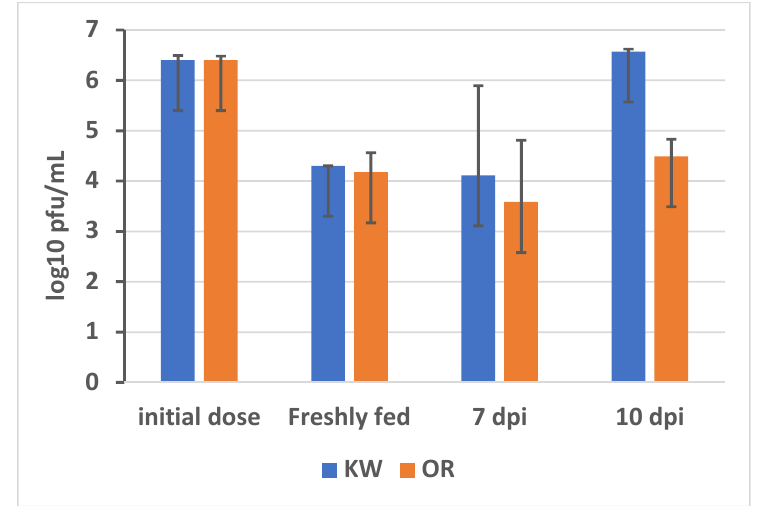
Figure 1. Zika virus titers in infectious blood meals and blood fed mosquitoes for permethrin resistant (KW) and susceptible (OR) strains of Aedes aegypti , including initial dose in bloodmeal, freshly fed, 7 days post infection (7 dpi), and 10 days post infection (10 dpi). Zika virus (strain PRVABC59, GenBank accession # KU501215.1) isolated from a human infected in Puerto Rico in 2015.